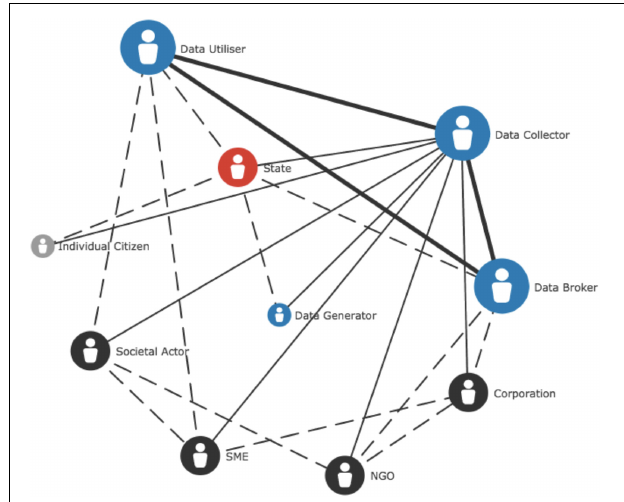
FIGURE 3 | Within the digital domain, and more specifically the domain of digital network providers, the state has limited powers and new actors emerge. These new actors command others through network-making and networked power, in a multitude of continuously changing relationships. Individual ownership of governance is limited. Governance over and within this network is thereby differentiated. This problematizes that power is dispersed throughout the network and is dependent on clusters/alliances of actors that can change per